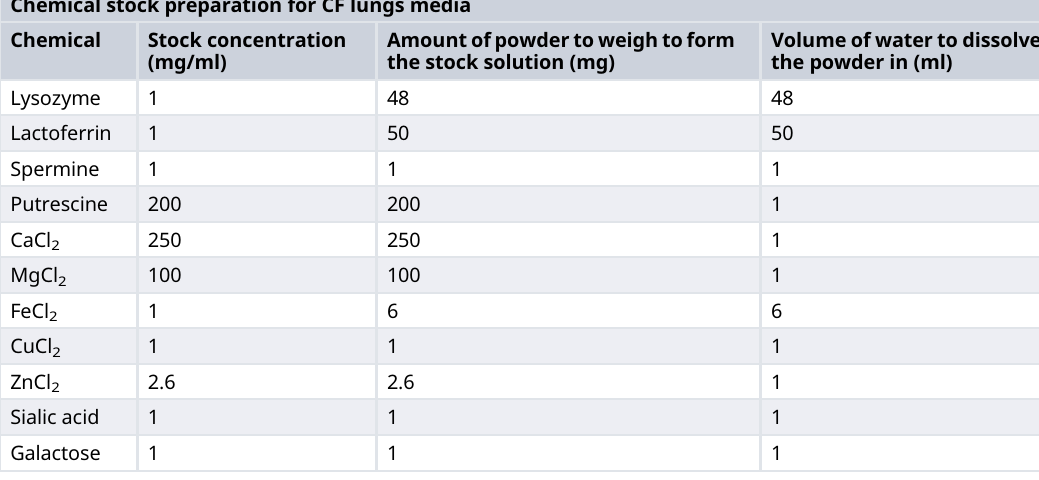
Table 7. Preparation of chemical stocks for CF lungs